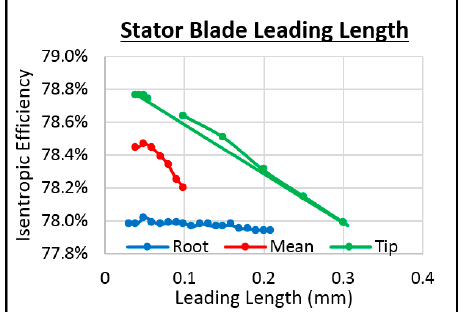
Figure 24. Study of the stator leading length.